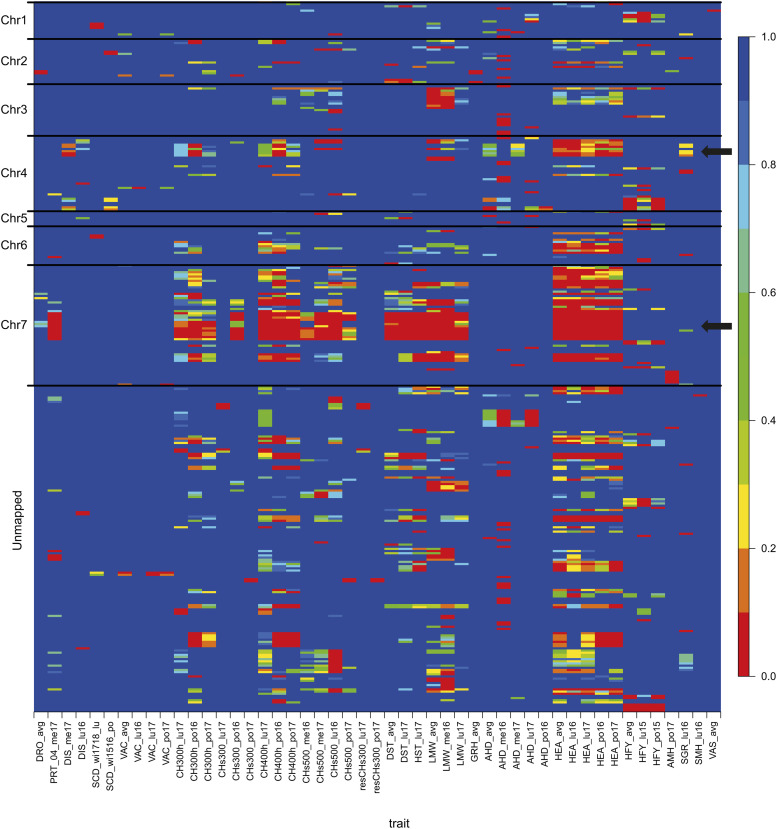
Heat map representing the q-value of associations between traits and SNP markers with the significant SNPs positioned along the different chromosomes (Chr1-Chr7 and unmapped from Byrne et al. 2015). The traits on the abscissa axis are those with which at least one SNP marker was significantly associated with a 10% q-value threshold and the positioned SNP markers are those associated with at least one trait (q-value < 10%). The two black arrows designate the remarkable regions on chromosome 4 and 7.